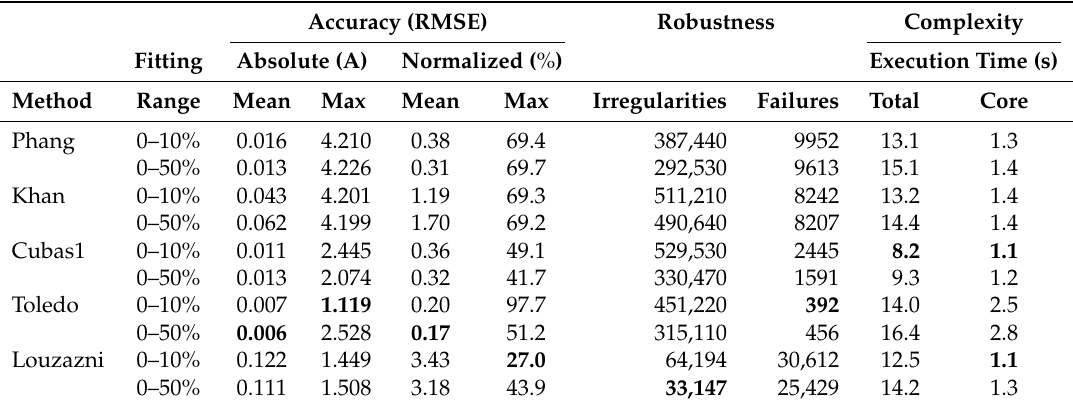
Table 6. Performance of the methods that require the SC slope as input data. Accuracy (RMSE) Robustness